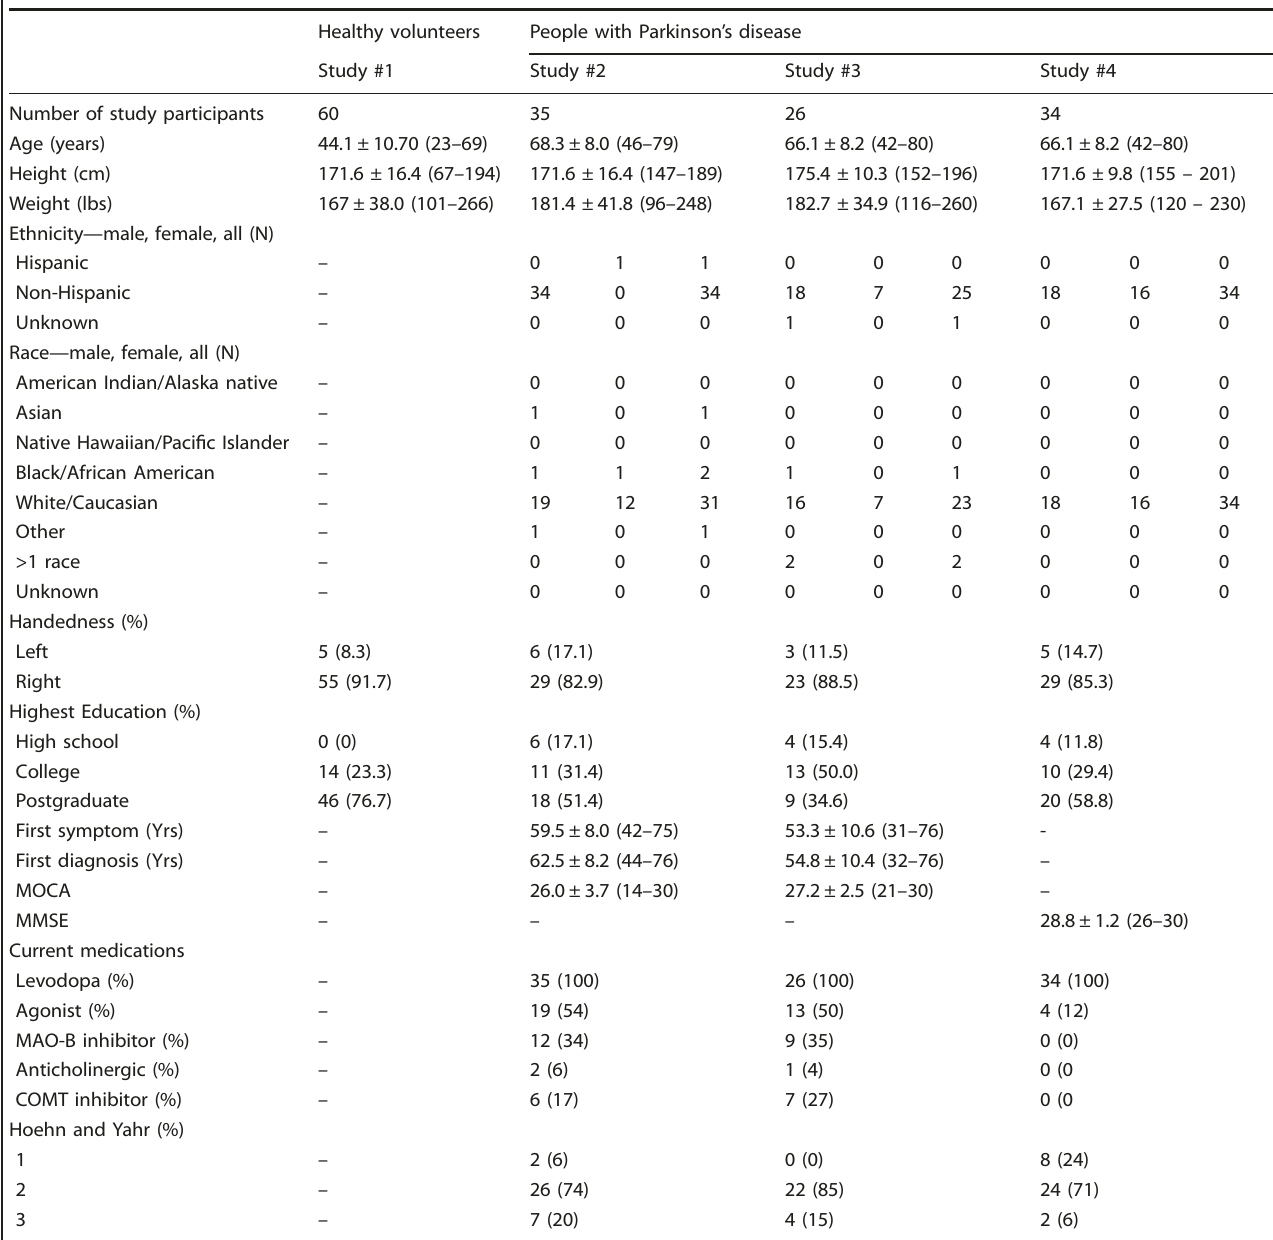
Table 1. Participant